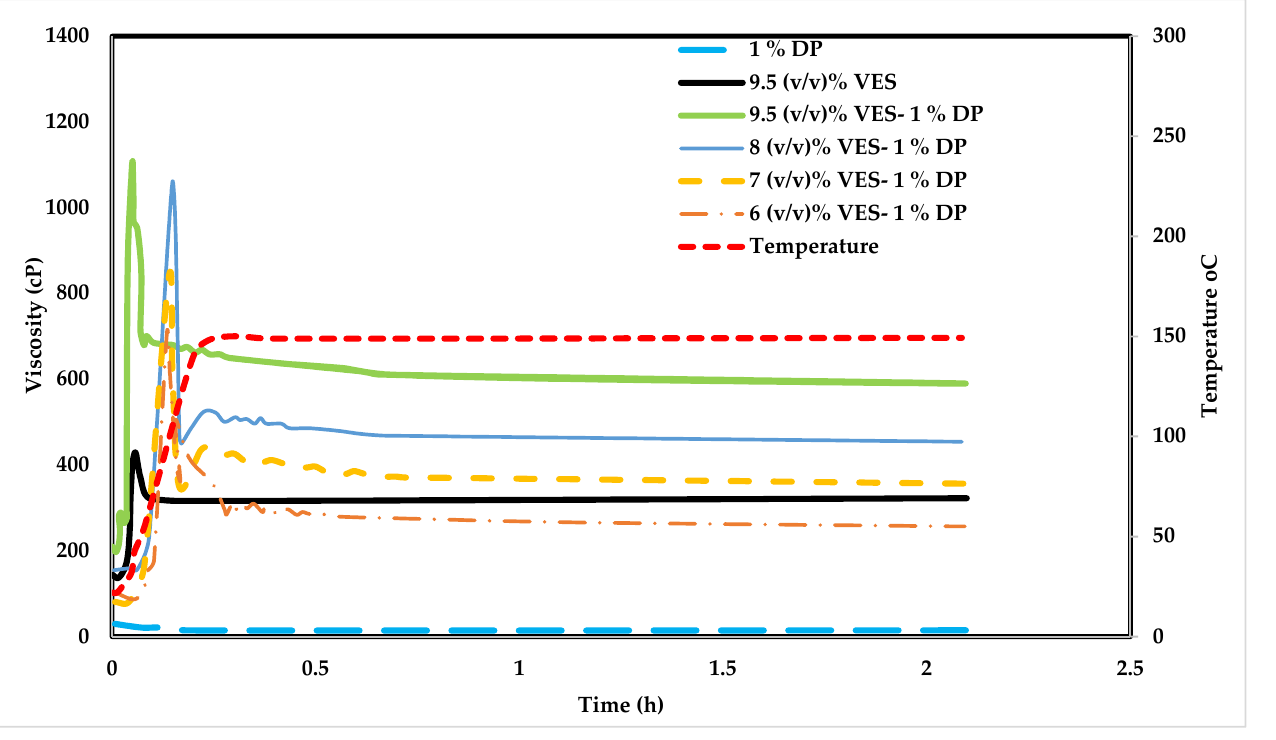
Figure 10. Different concentrations of VES Fluid prepared with 30% w/v CaCl 2 in sea water, at 1% of DP polymer.